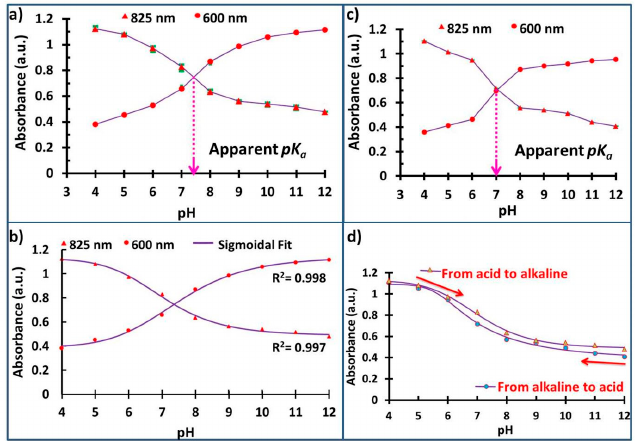
Figure 5. Graphs of the absorbance change vs. pH for PANI-PSU-20 membranes during forward titrations, pH 4 → pH 12, ( a ); and backward titrations, pH 12 → pH 4, ( c ); Dual wavelength calibration curves for the pH dependence of the absorption at 600 and 825 nm ( b ); and the pH titration curves demonstrating hysteresis at 825 nm ( d ).